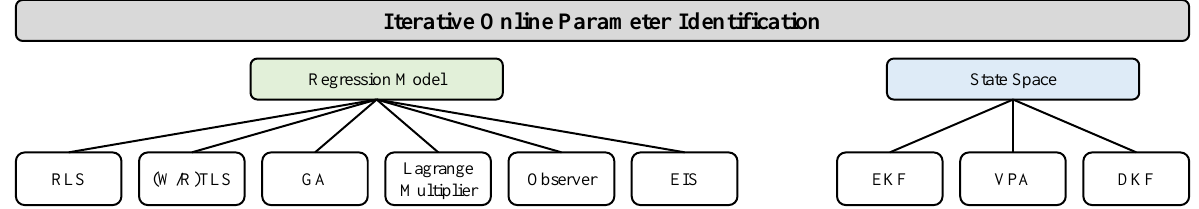
Figure 4. Overview of modeling and online parameter identification methods and the corresponding